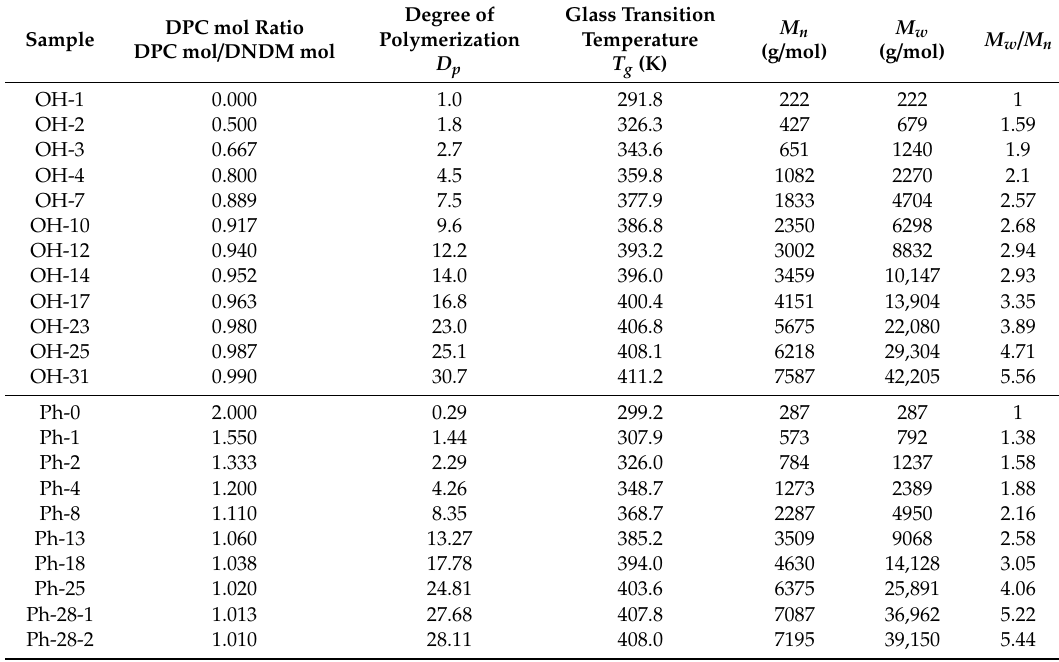
Table 2. Numerical data of hydroxy end group (OH-n) and phenolic end group (Ph-n) DNDM monomers, oligomers, and polymers discussed including T g and molecular weight on D p.